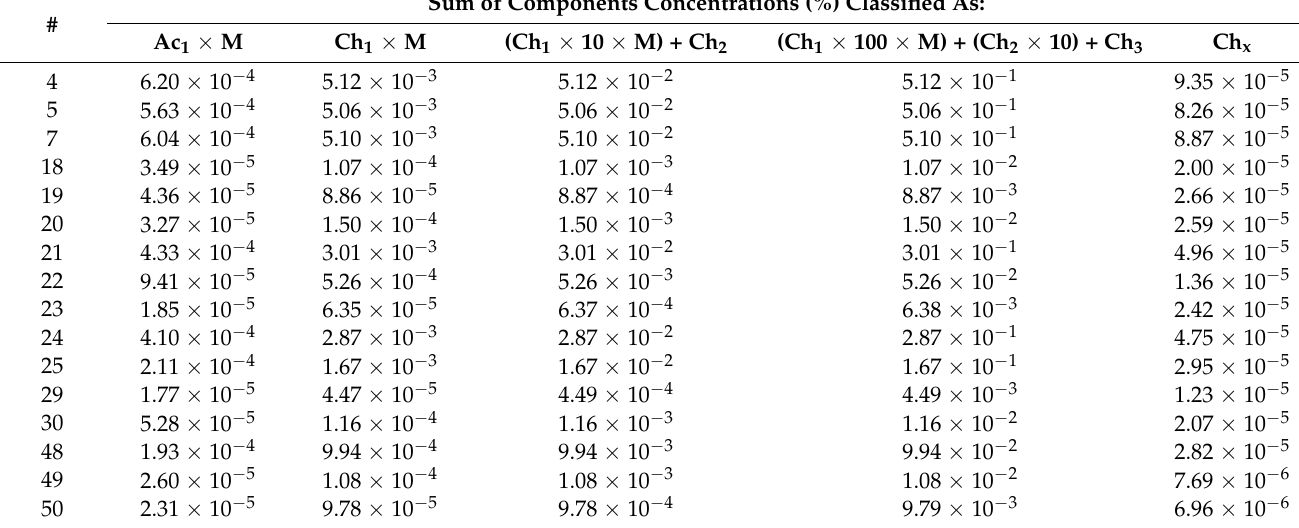
Table 7. Calculations for hazard level